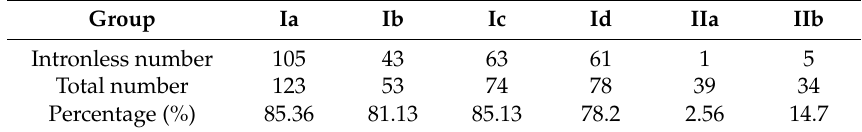
Table 4. Statistics for numbers of intronless members within different groups of the SAP gene family. Group Ia Ib Ic Id IIa IIb Intronless number 105 Total number